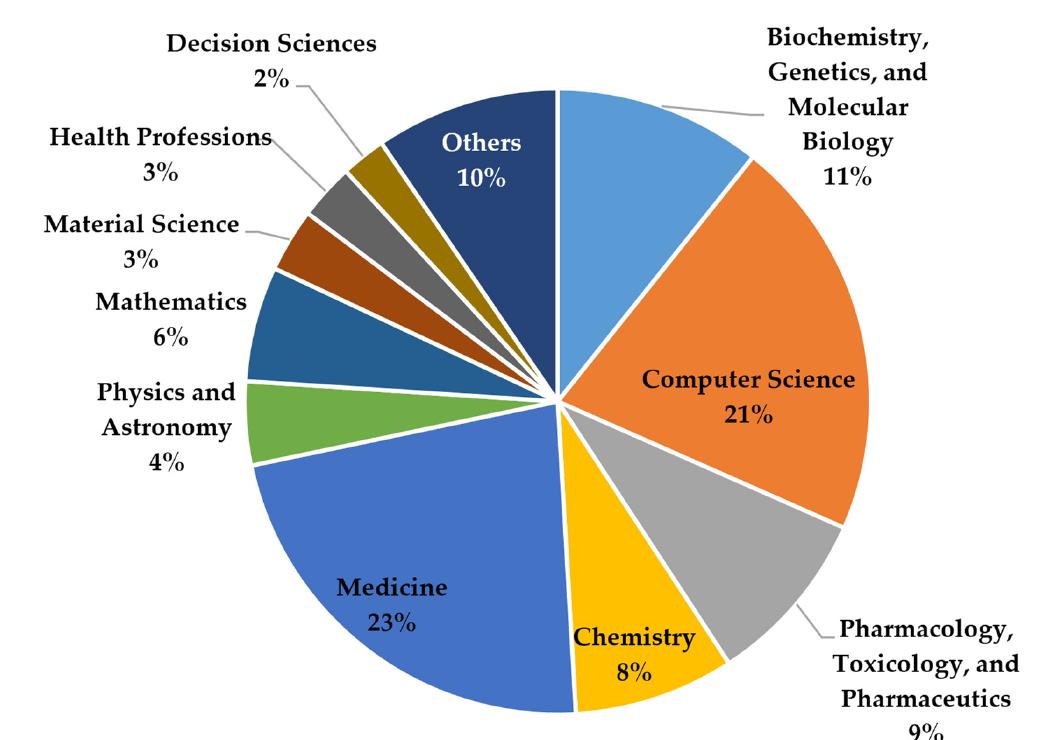
Figure 3. Overview of the most contributing disciplines.